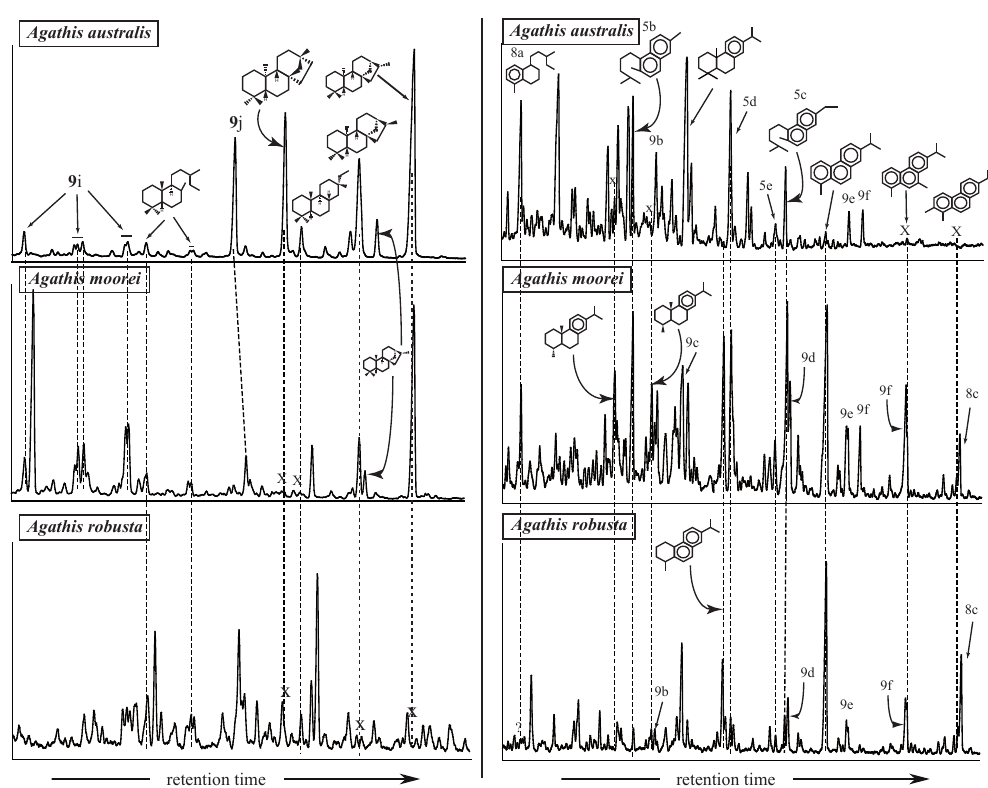
Fig. 11. Partial chromatograms (diterpenoids retention time windows) of aliphatic (left) and aromatic (right) fractions of pyrolysates of Agathis species. The mass spectra of 5b to 5e are given in Fig. 5. The mass spectra of 8a and 8c are given in Fig. 8. The mass spectra of 9b to 9j are given in Fig. 9. x : absence of